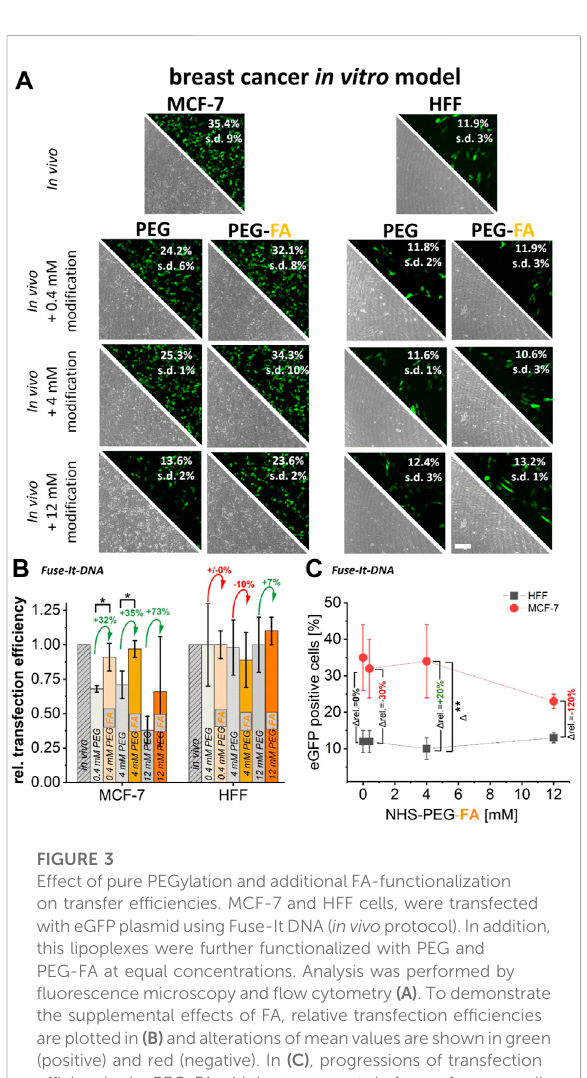
FIGURE 4 Effect of pure PEGylation and additional FA-functionalization on transfer ef fi ciencies. In U87 glioblastoma cells and primary cortical neurons, eGFP plasmid was transferred using Lipofectamine ® 3000 ( in vivo applicable protocol). In addition, this protocol was further modi fi ed with PEG and PEG-FA at equal concentrations. Analysis was performed by fl uorescence microscopy and fl ow cytometry (A) . To demonstrate the supplemental effects of FA, relative transfection ef fi ciencies are plotted in (B) and alterations of mean values are shown in green (positive) and red (negative). In (C) , progressions of transfection ef fi ciencies by PEG-FA with improvements in favor of cancer cells shown in green and deteriorations in red are shown. Scale bar 200 μ m. n = at least three independent